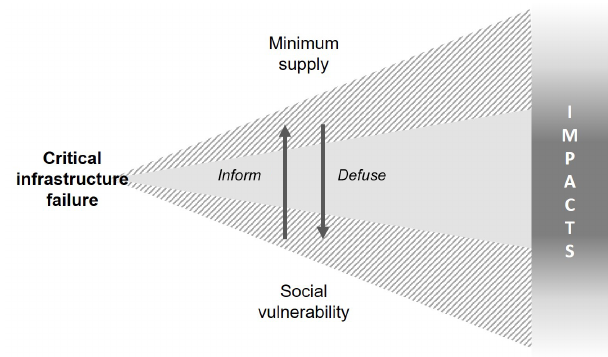
Figure 3. Heuristic model for capturing the relationship between critical infrastructure failure, minimum supply and social vulnera-